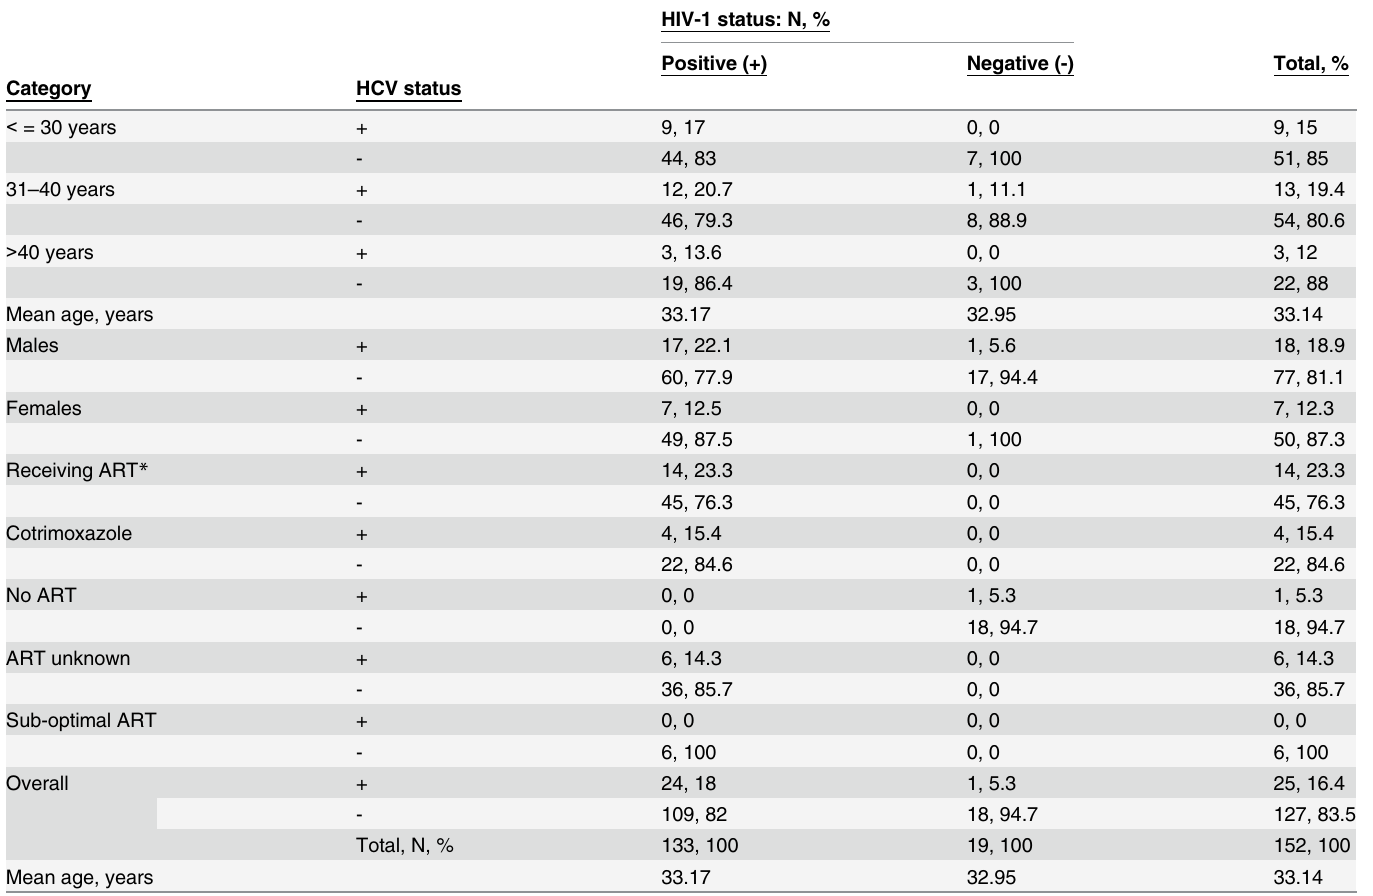
Table 2. Prevalence of HIV-1 and HCV mono and dual infections among heroin